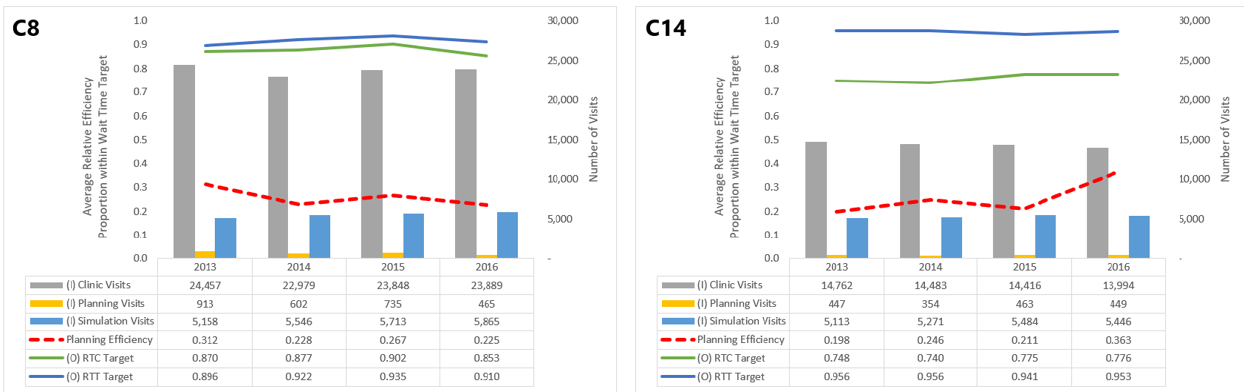
Figure 4. Comparing planning dimension performance: C8 and